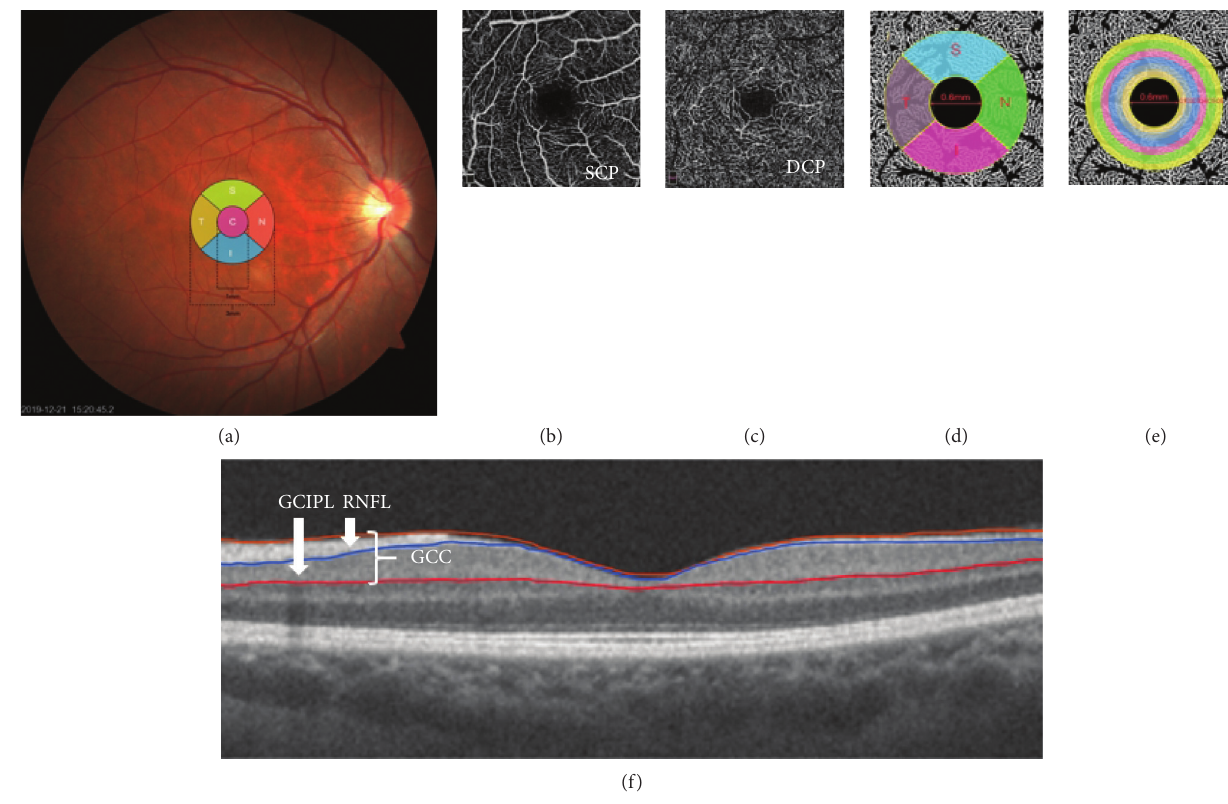
Figure 1: Retinal structure and the corresponding microvascular density and fractal dimension in superficial and deep layers imaged by OCT/OCTA. (a) Five regions within a 3mm area around the fovea: (C) central region; (S) superior; (T) temporal; (I) inferior; (N) nasal. (b, c) OCTA images of superficial capillary plexuses (SCP) and deep capillary plexuses (DCP) in 3 × 3 mm area around fovea. (d, e) Fractal dimension analysis in four quadrants and six annular zones excluding the avascular zone (diameter � 0.6 mm): C1 (diameter � 0.92mm), C2 (diameter � 1.23mm), C3 (diameter � 1.55 mm), C4 (diameter � 1.87mm), C5 (diameter � 2.18mm), and C6 (diameter � 2.50mm). (f) Retinal nerve fiber layer (RNFL) and ganglion cell complex (GCC) thickness around the fovea. GCIPL � ganglion cell-inner plexiform layer. Table 2: The numbers of eyes examined in all three